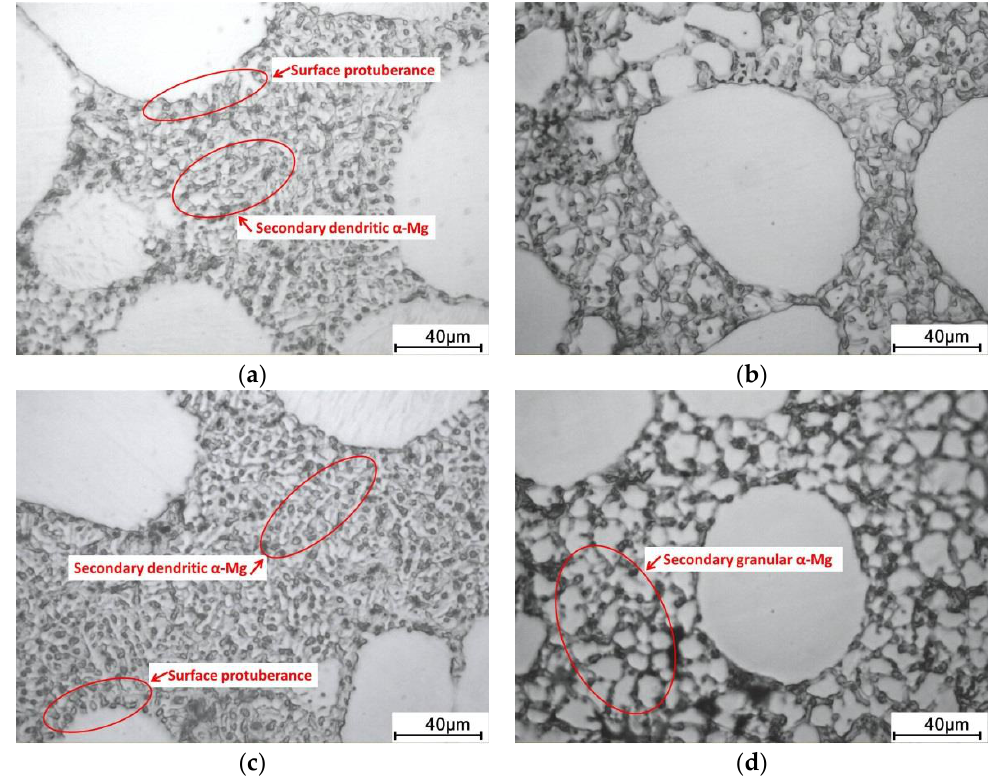
Figure 7. Solidification microstructure of the remaining liquid in rheo-diecast AZ31 alloy with a solid fraction of 42% ( a , c ) and 61% ( b , d ) under different injection velocities. ( a , b ) 0.5 m/s; ( c , d ) 3 m/s.